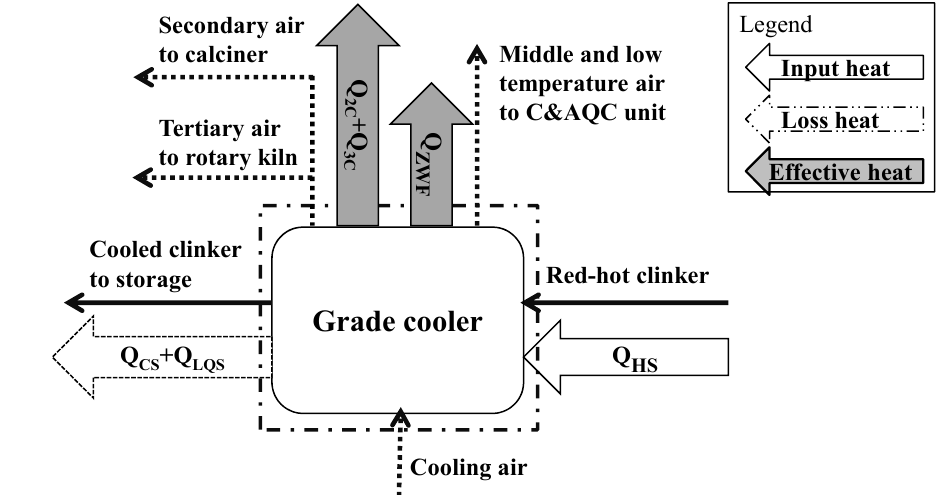
Figure 5. Heat flow modelling of the Cooling unit.